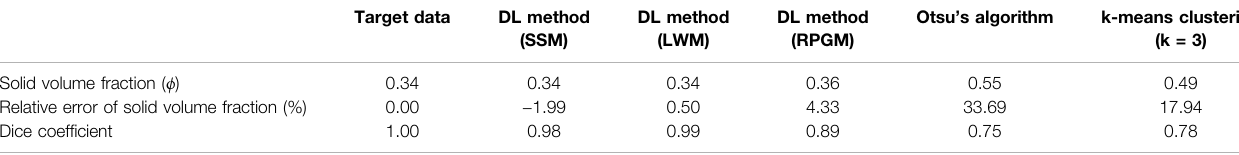
TABLE 4 | Impact of preprocessing on segmentation performance for real hnpg_epoxy dataset.